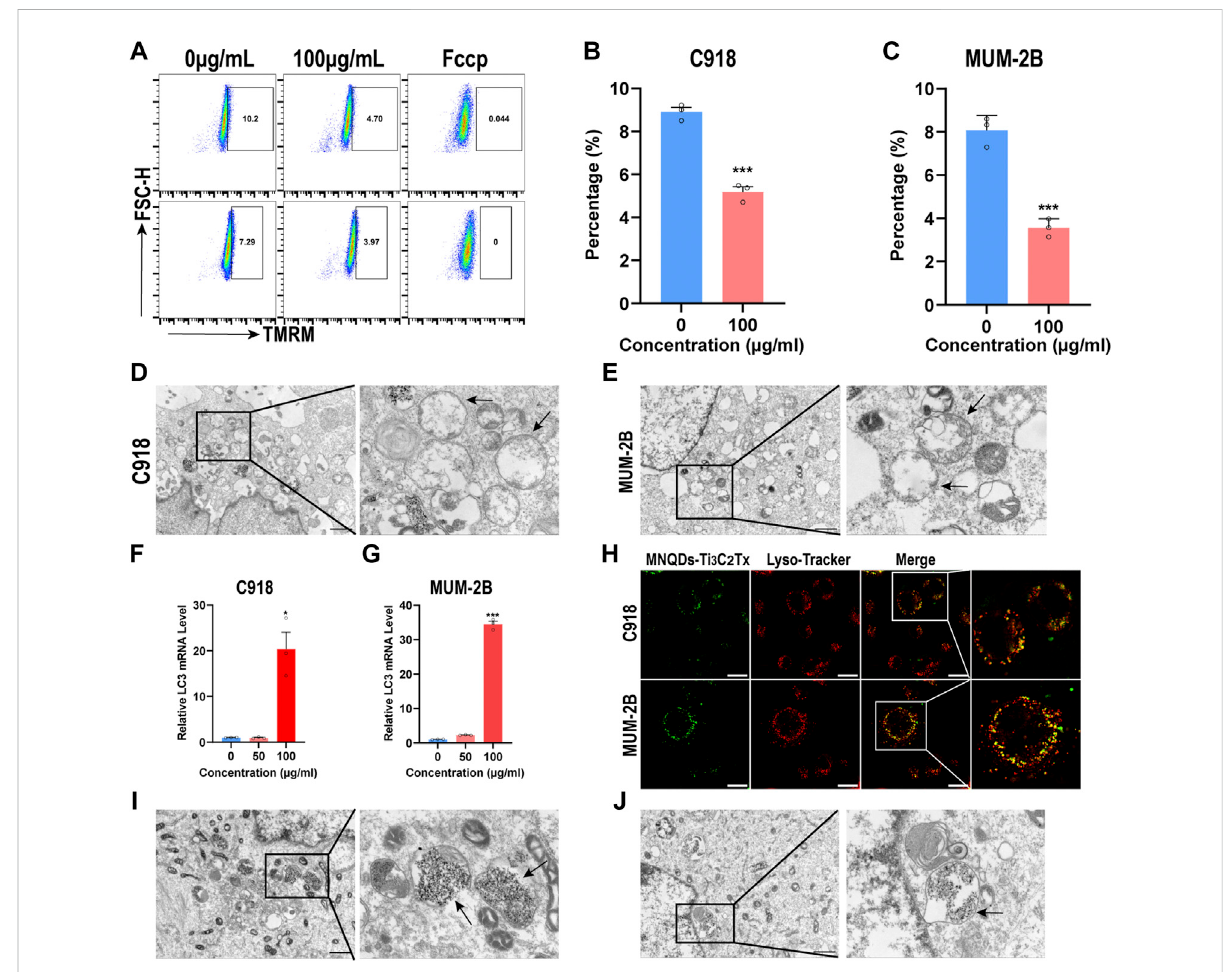
FIGURE 6 NMQDs-Ti 3 C 2 Tx induces mitophagy and lysosome destruction in UM cells (A,B and C) The levels of MMP in UM cells treated with different concentrations ofNMQDs-Ti 3 C 2 Txwere determined using fl ow cytometrycoupled with TMRM staining.Fccp was used as thenegative control with lowMMP (n=3,*** p < 0.0005) (DandE) Bio-TEM imageandpartial enlarged images ofUM cellsafter treatedwith100 μ g ml − 1 ofNMQDs-Ti 3 C 2 Tx. The black arrows point to mitochondrial edema. Scale bar: 10 μ m. (F and G) The LC3 RNA levels of UM cells after 6 h of stimulation with 100 μ g ml − 1 of NMQDs-Ti 3 C 2 Tx. GAPDH was used as a loading control (n = 3; * p < 0.05, *** p < 0.0005) (H) Colocalization of NMQDs-Ti 3 C 2 Tx